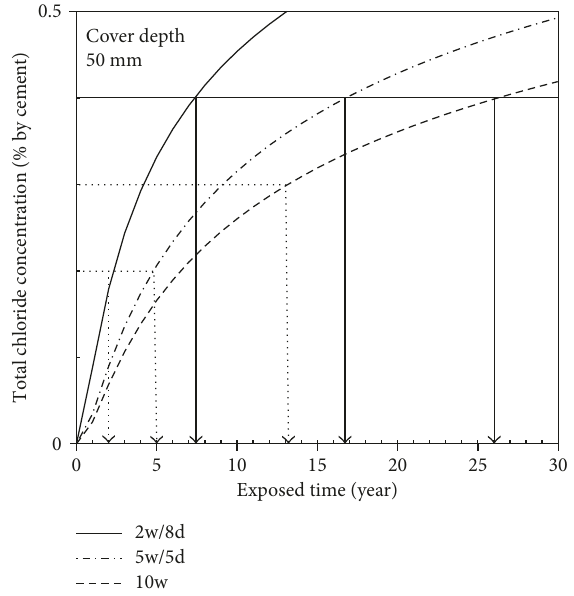
Figure 6: Prediction of chloride concentration with time (cover depth: 50